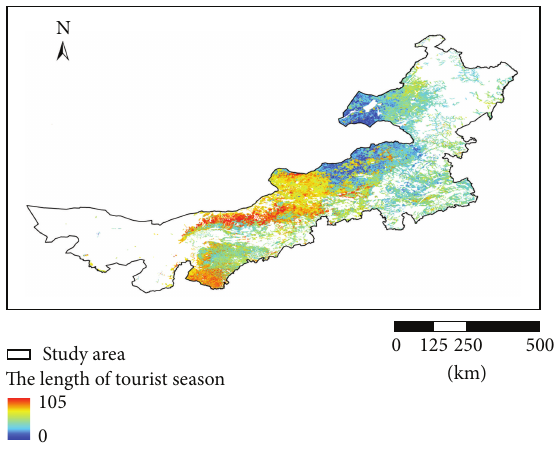
Figure 7: The length of grassland tourist